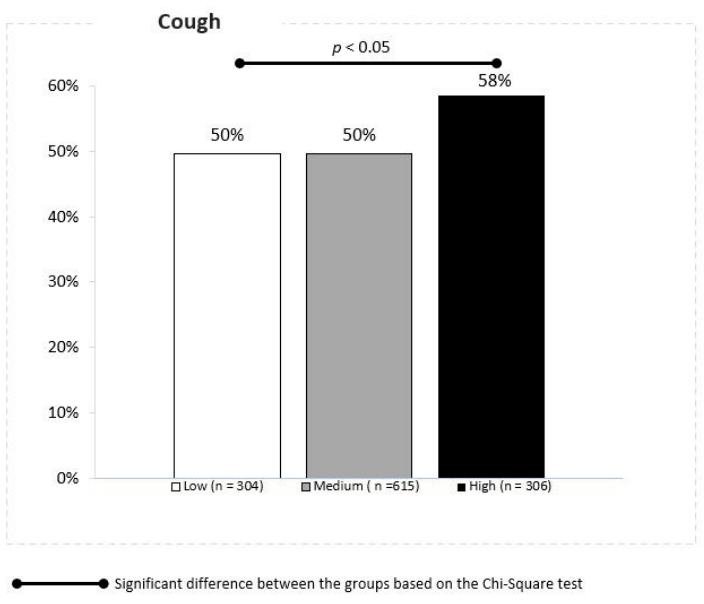
Figure 3. Association between the PM 10 concentrations and cough.